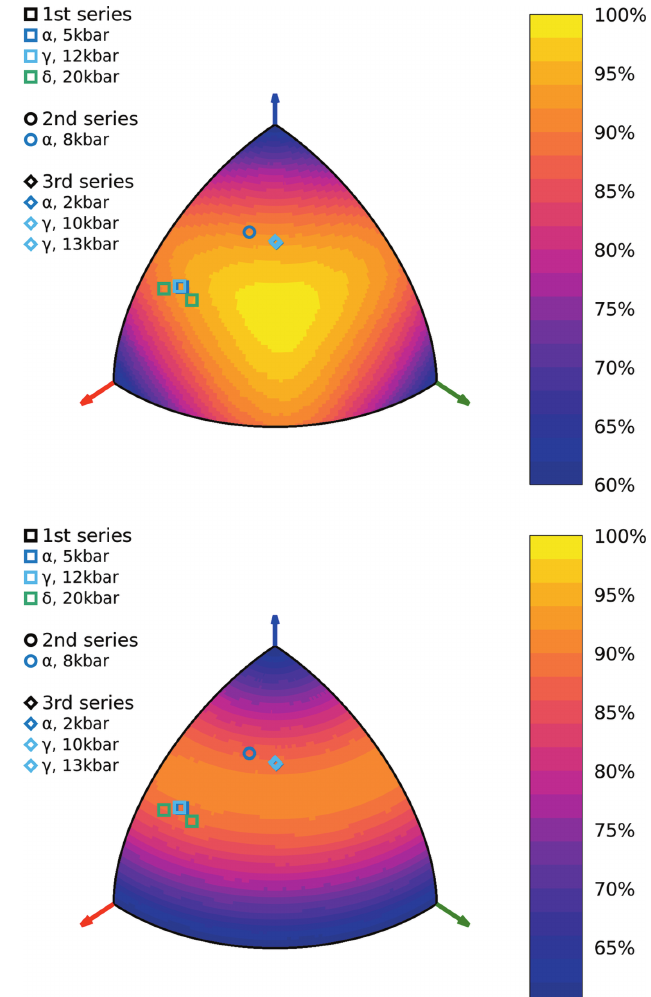
Figure 7 Potency heat maps prepared for 2 (cid:2) AP- (cid:2) , 2 (cid:2) AP- (cid:3) and 2 (cid:2) AP- (cid:4) in the initial Laue class mmm (top), and in the final 2/ m (bottom), assuming an opening angle of 55 (cid:2) and a 0.6 A˚ (cid:3) 1 resolution. The sample orientations in the HP experiments performed are marked; marked colors represent crystal phases and marked shapes correspond to individual packing series. As expected, the orientation is preserved in individual series, the only exception being (cid:4) , whose two domains appear during phase transition- induced